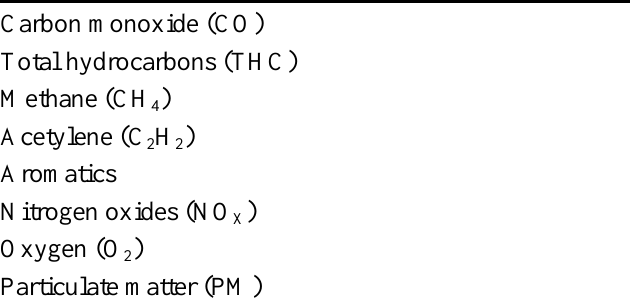
Table 2. Analyzed compounds and sum